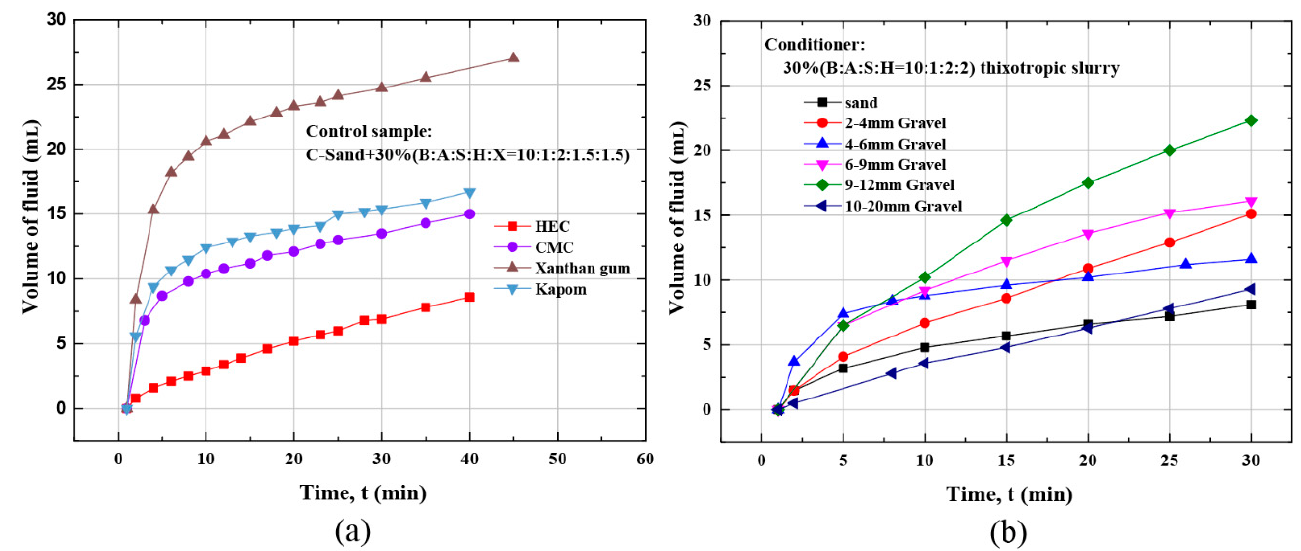
Figure 9. ( a ) Effect of two polymers mixing on seepage flow. ( b ) Effect of B/A/S/H at the optimal ratio on gravel impermeability.